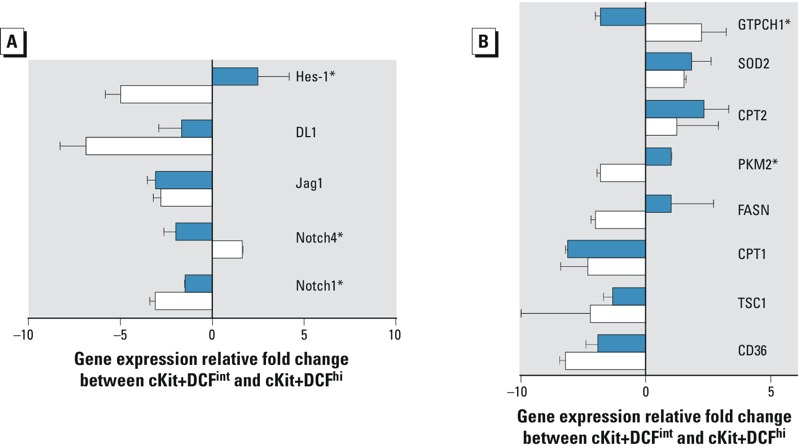
Impact of developmental ­tetrachlorodibenzo-­p-dioxin (TCDD) exposure on ­differentiation-­induced changes in gene expression in hematopoietic progenitor cells. Hematopoietic stem and progenitor cells were purified by fluorescence activated cell sorting as illustrated in Figure 2A and with the sorting strategy shown in Figure S4. (A) Gene expression changes associated with Notch signal transduction between ­c-­Kit+DCFint and ­c-­Kit+DCFhi cells from control fetuses (white bars) and ­TCDD-­exposed fetuses (blue bars). (B) Gene expression changes associated with cellular metabolism (CD36, TSC1, CPT1, CPT2, FASN, PKM2) and oxidative stress (SOD2, GTPCH1) in ­c-­Kit+DCFint and ­c-­Kit+DCFhi cells from control fetuses (white bars) and ­TCDD-­exposed fetuses (blue bars). Data are presented as the mean ± standard deviation of replicate wells from a single quantitative polymerase chain reaction (qPCR) reaction with the experiment performed on two independent litters of mice.
*p ≤ 0.05, statistical significance between the two treatments (Student’s ­t-­test).